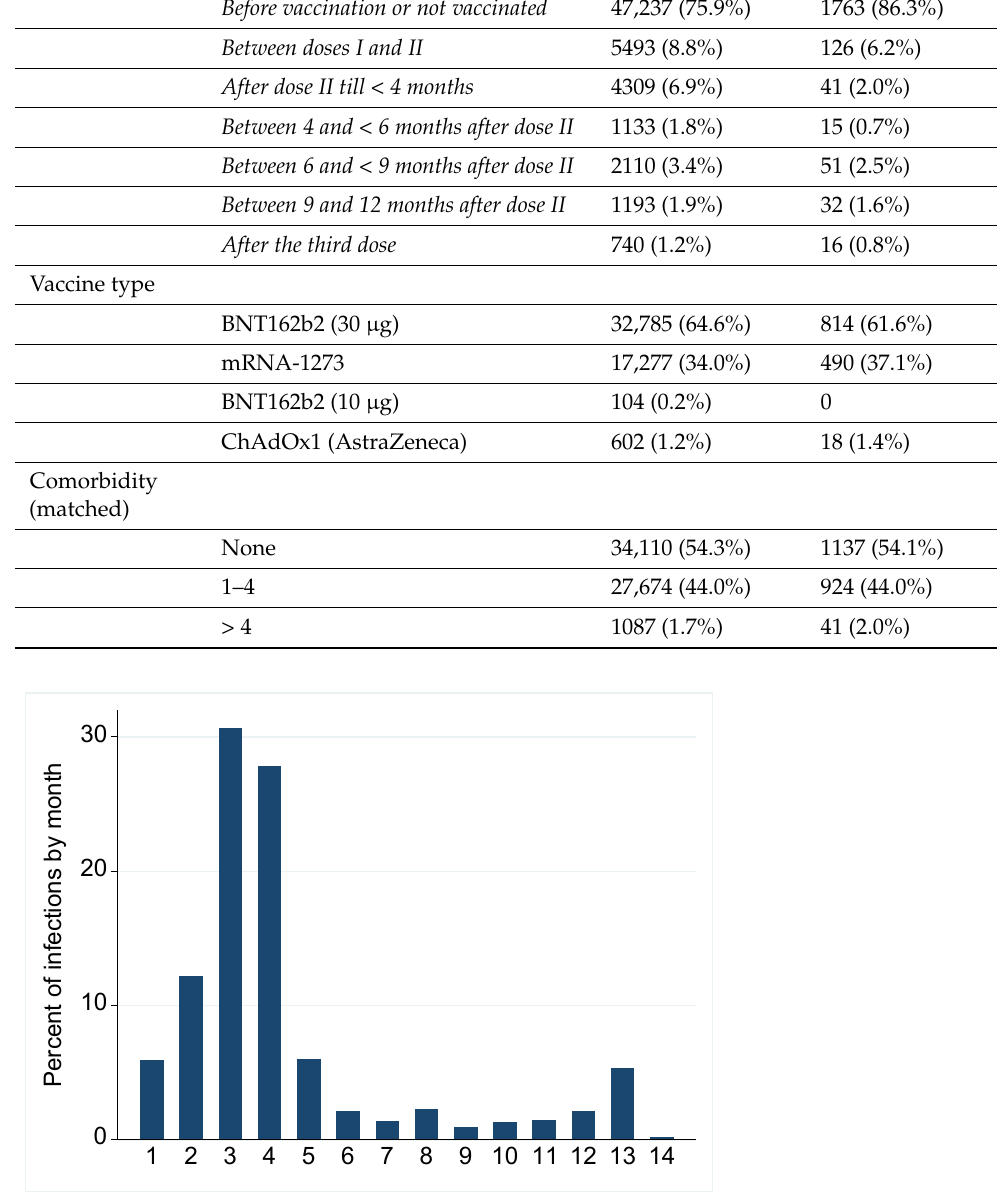
Figure 1. Percentage of cases by month among the participants of the case-control study. The two major waves are depicted over the 14-month study period (1–12 are January–December 2021, and